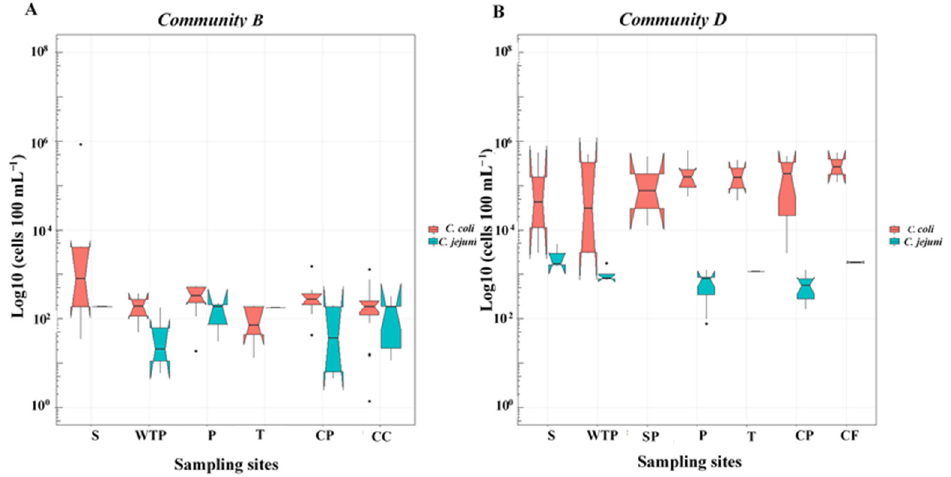
Figure 2. Concentration (cells 100 mL − 1 ) of C. jejuni and C. coli in pre- and post-treatment samples collected from DWDS of two communities (panels A and B ).